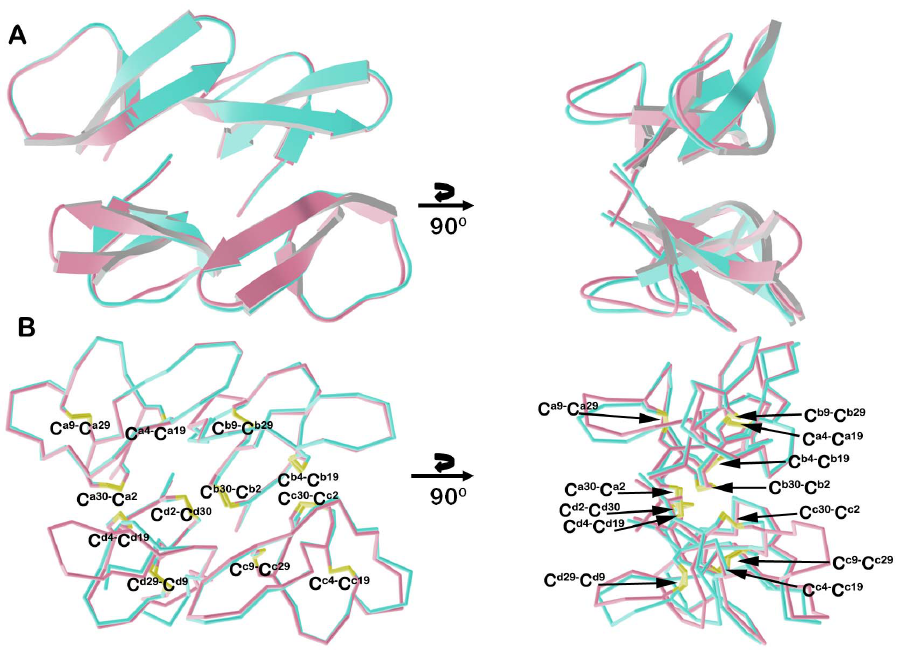
doi:10.1371/journal.pone.0078937.g004